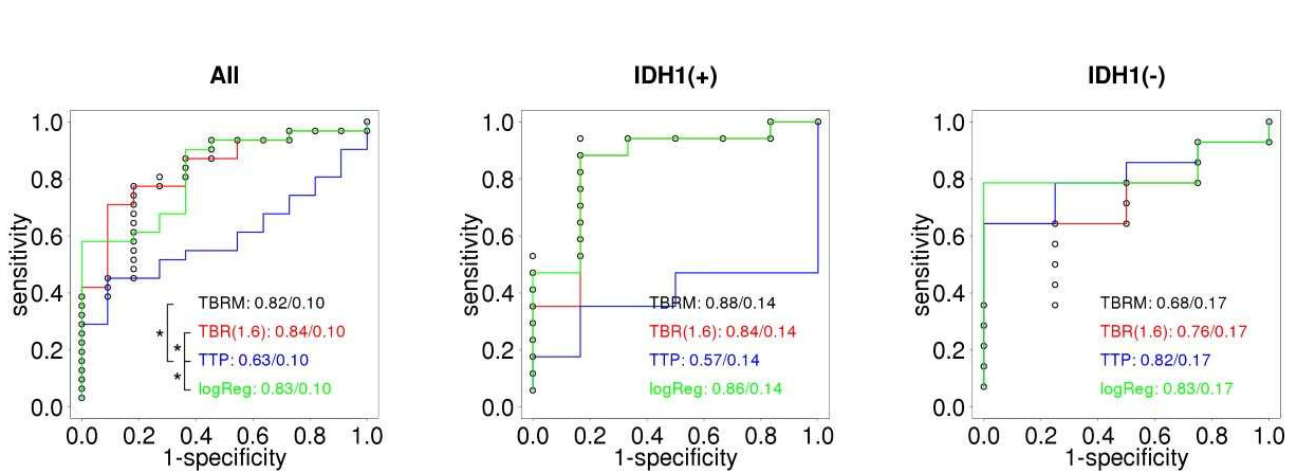
Figure 1. Receiver–operator characteristic (ROC) curves in classifying tumor outcome based on FET-derived parameters for different IDH mutation status groups. All: all patients in the study. IDH1(m): patients with mutated IDH gene. IDH1(wt): patients with IDH wild type. TBRM is TBR max , TBR(1.6) is TBR mean at SUV 1.6 g/mL cutoff, TTP is time to peak and log Reg is the logistic regression model. The image shows AUC values with associated standard deviation. The asterisk associated brackets identify variables with statistically significant ROC curves as evaluated by a non-parametric significance test. Table 1. Analysis of sensitivities, specificities, thresholds and diagnostic accuracy of 18 F-FET PET biomarkers in differentiation between late TP and TRC in glioma patients